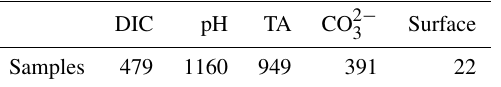
Table 9. Total number of CO 2 system samples analyzed during the MSM72 cruise. The total number of fired bottles was 1723. DIC pH TA CO 2 −